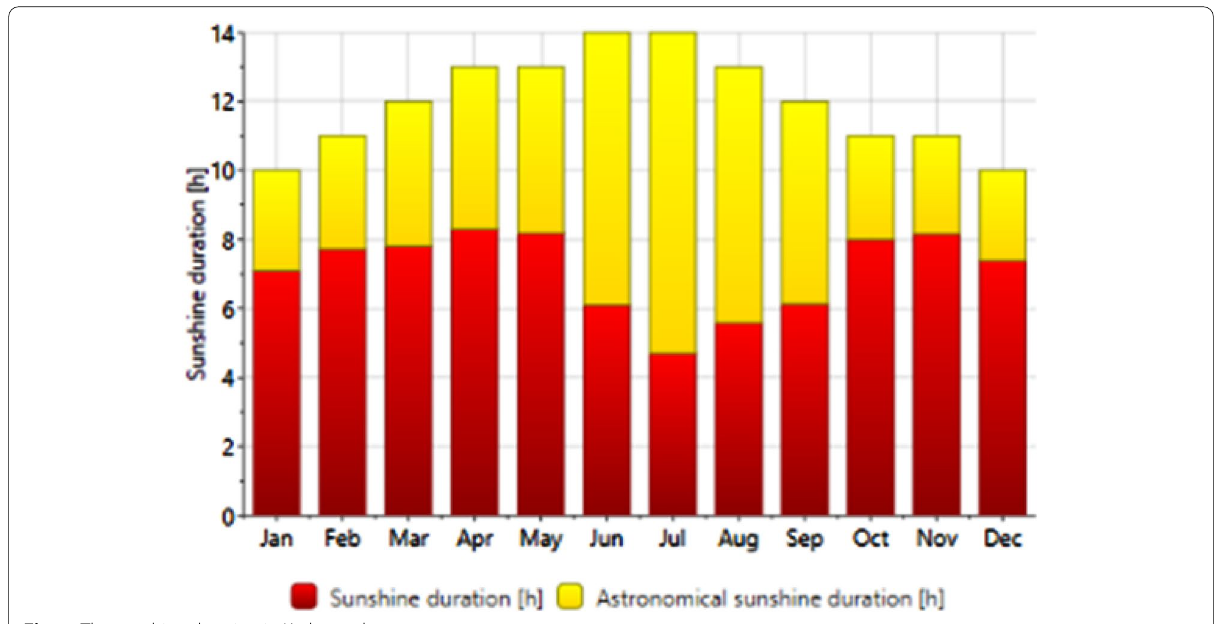
Fig. 5 The sunshine duration in Kathmandu